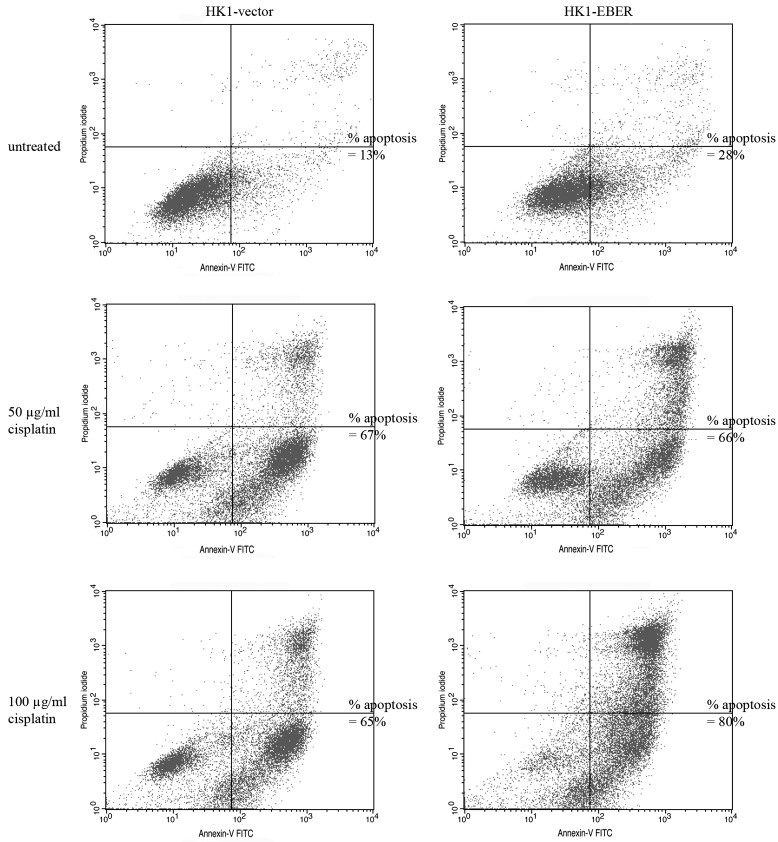
Flow cytometry analysis using Annexin V-FITC/PI double staining showing apoptosis. Cells were exposed to cisplatin 24 h prior to analysis. The lower right and upper right quadrants are cells undergoing apoptosis. Images shown are representative of three independent experiments. Average percentage of total apoptotic cells is indicated.